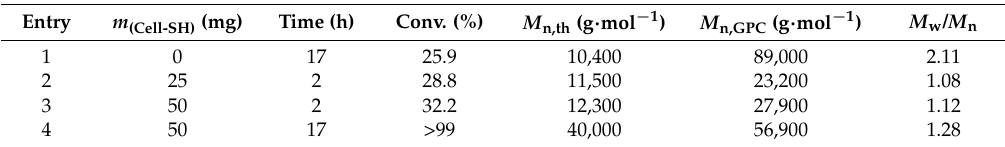
Table 1. Effect of the amount of Cell-SH on the AGET ATRP with thiol-functional cell paper as the reducing agent.